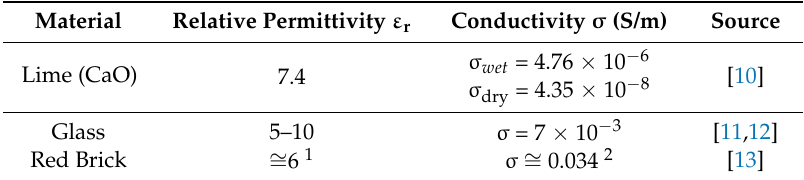
Table 1. Typical electric properties of building materials.